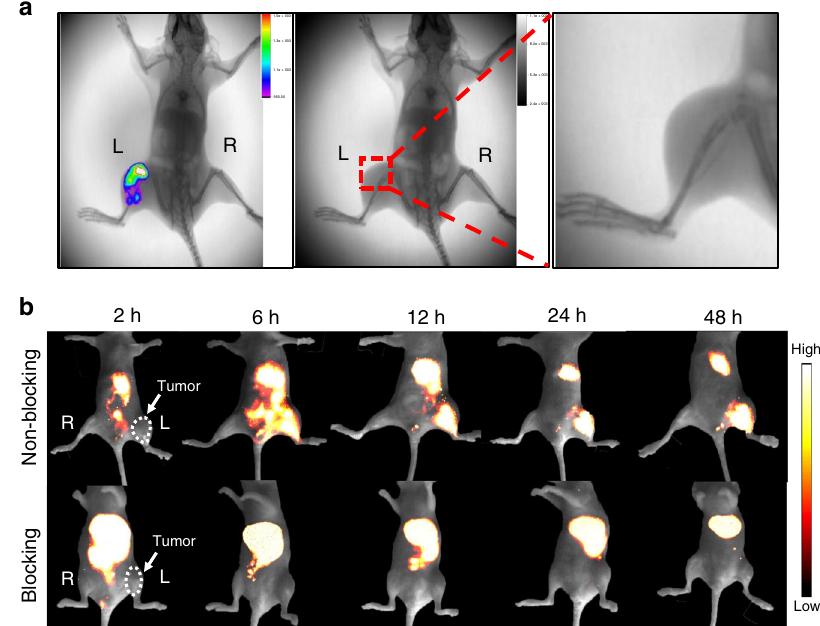
Fig. 7 In vivo imaging of osteosarcoma. a Merge of X-ray and bioluminescence imaging of orthotopic 143B tumor in the nude mouse (left), X-ray imaging of orthotopic 143B tumor in the nude mouse (middle) and enlarged images of proximal tibia of the joint (right) (prone position) ( n = 3 biologically independent mice). b NIR-II signals of H4-PEG-PT in 143B tumor mice (top) and the blocking group (bottom) under 808 nm excitation (1000 LP, 3.5 W, 250 ms) (supine position) ( n = 3 biologically independent